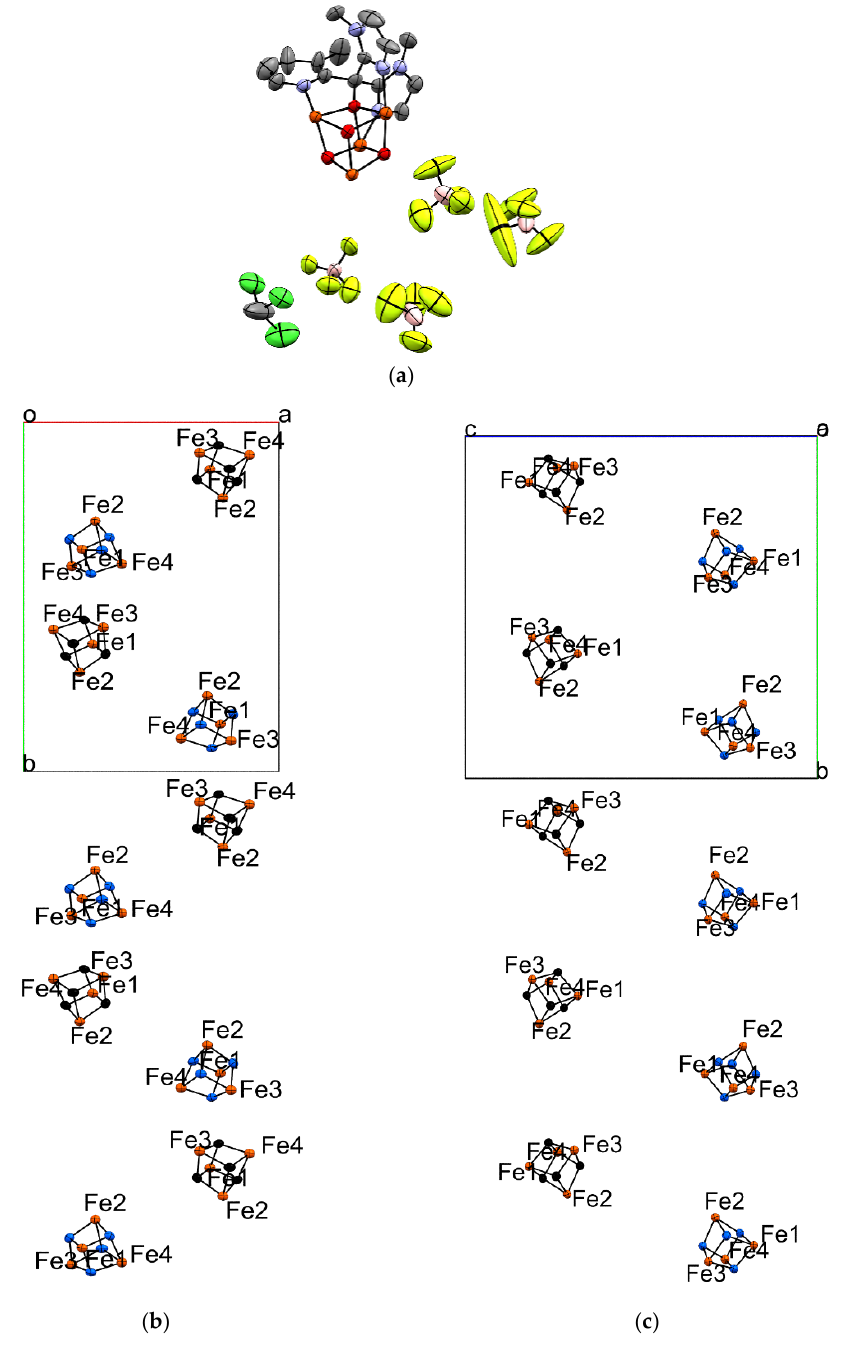
Figure 5. ( a ) Distorted [Fe 4 -(µ 3 -O) 4 ]-cubane core in 4 decorated with 2-methylimidazole/2-methylpyridine ligands (3 ligands and hydrogen omitted for clarity). Color code: Fe orange, O red, Cl green, F yellow, B pink. ( b ) Helical alignment of [Fe 4 O 4 ]-cubane cores in 4 along the b -axis, view along c -axis (((mim) 2 (mpy)CO) ligands omitted for clarity). ( c ) Location of [Fe 4 O 4 ]-cubane cores in 4 along the b -axis on the 2 1 screw-axis, view along a -axis (((mim) 2 (mpy)CO); ligands omitted for clarity).